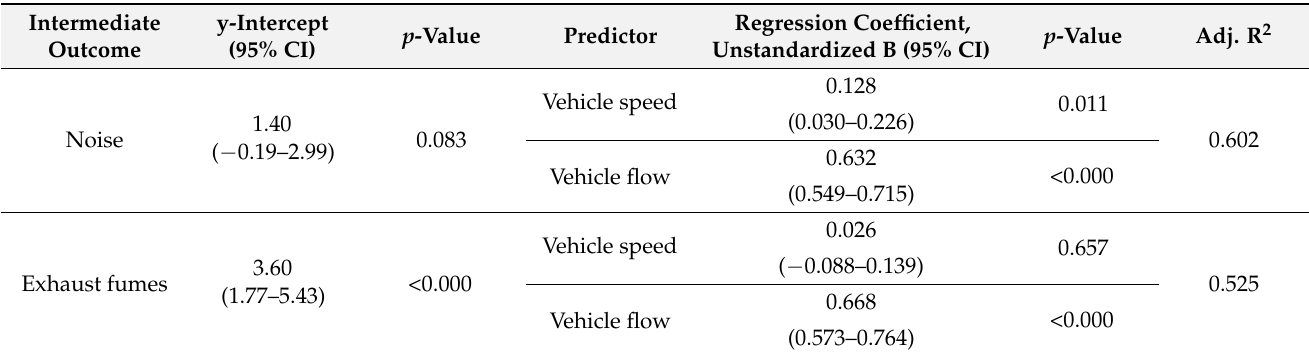
Table 6. Relations between the basic variables vehicle speed and vehicle flow and the intermediate outcomes noise and exhaust fumes.